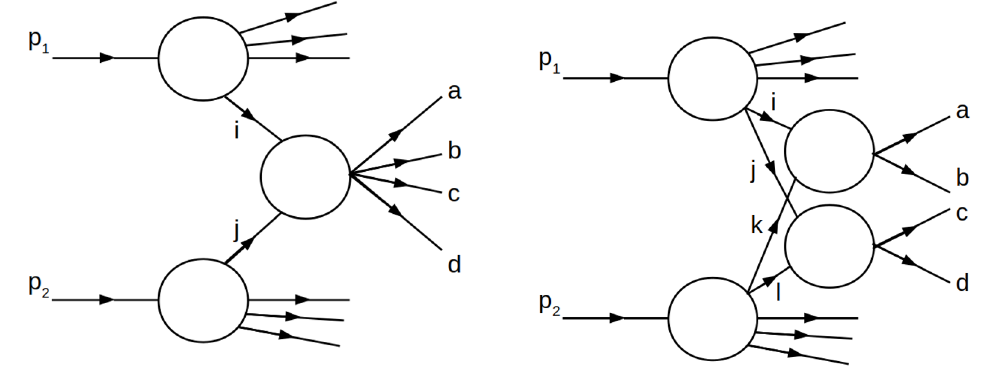
Figure 1 . A schematic depiction of inclusive four-jet production through SPS (left) and DPS (right). In the case of SPS, one hard scattering produces the jets a through d , whereas two inde- pendent hard scatterings create two jets each in the case of DPS. Since the two jet pairs are created independently in a DPS event, they are expected to show different kinematic correlations compared with the four jets originating from an SPS